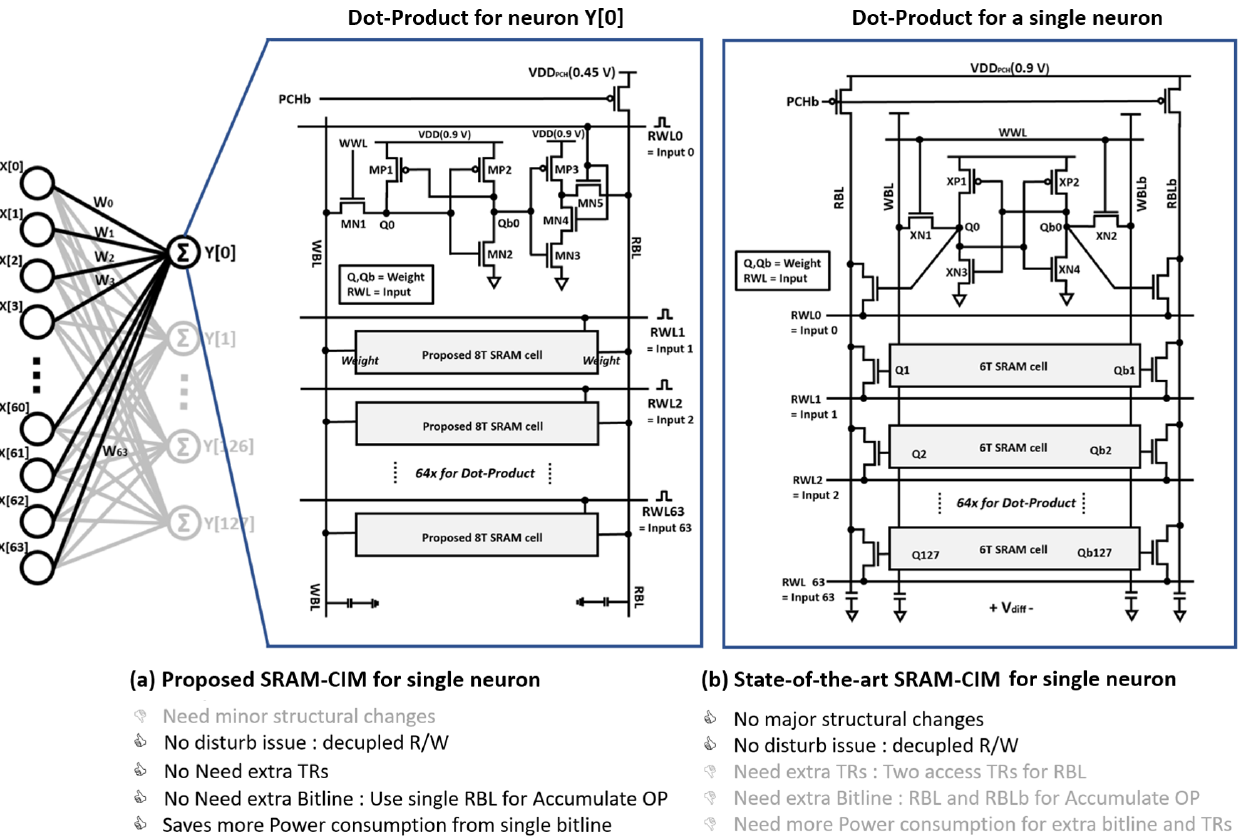
Figure 1. Comparison of ( a ) proposed 8T-based SRAM-CIM for 64 × dot-product cell array and ( b ) the-state-of-the-art 6T-based SRAM-CIM